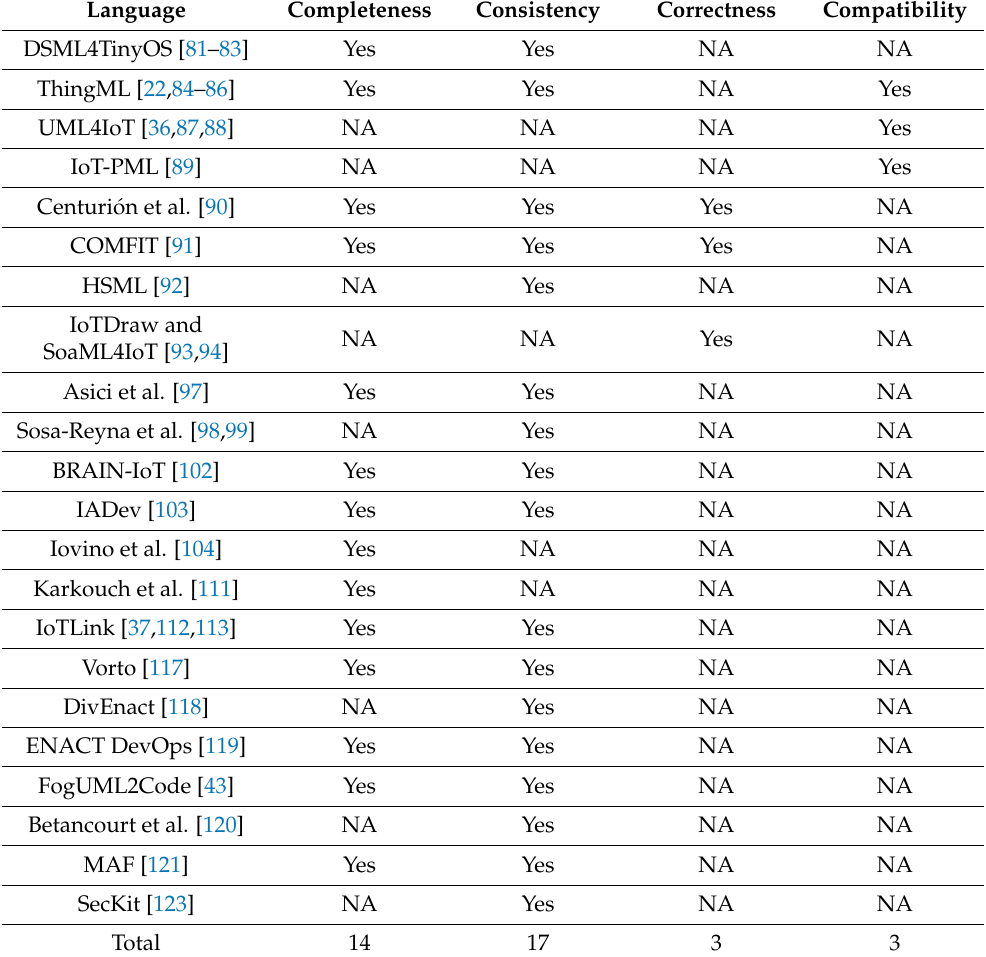
Table 6. The modeling languages for IoT that support the model analysis for the completeness, consistency, correctness, and compatibility